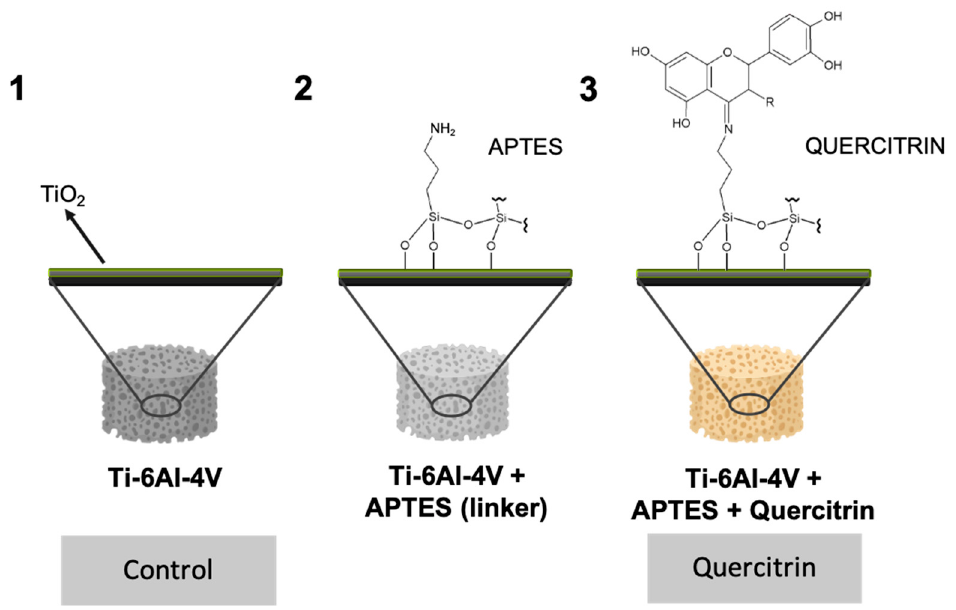
Figure 1. Schematic representation of quercitrin coating on Ti-6Al-4V porous implants, and Figure1. SchematicrepresentationofquercitrincoatingonTi-6Al-4Vporousimplants, andexperimental experimental groups used in the study, control and quercitrin-coated implants. groups used in the study, control and quercitrin-coated